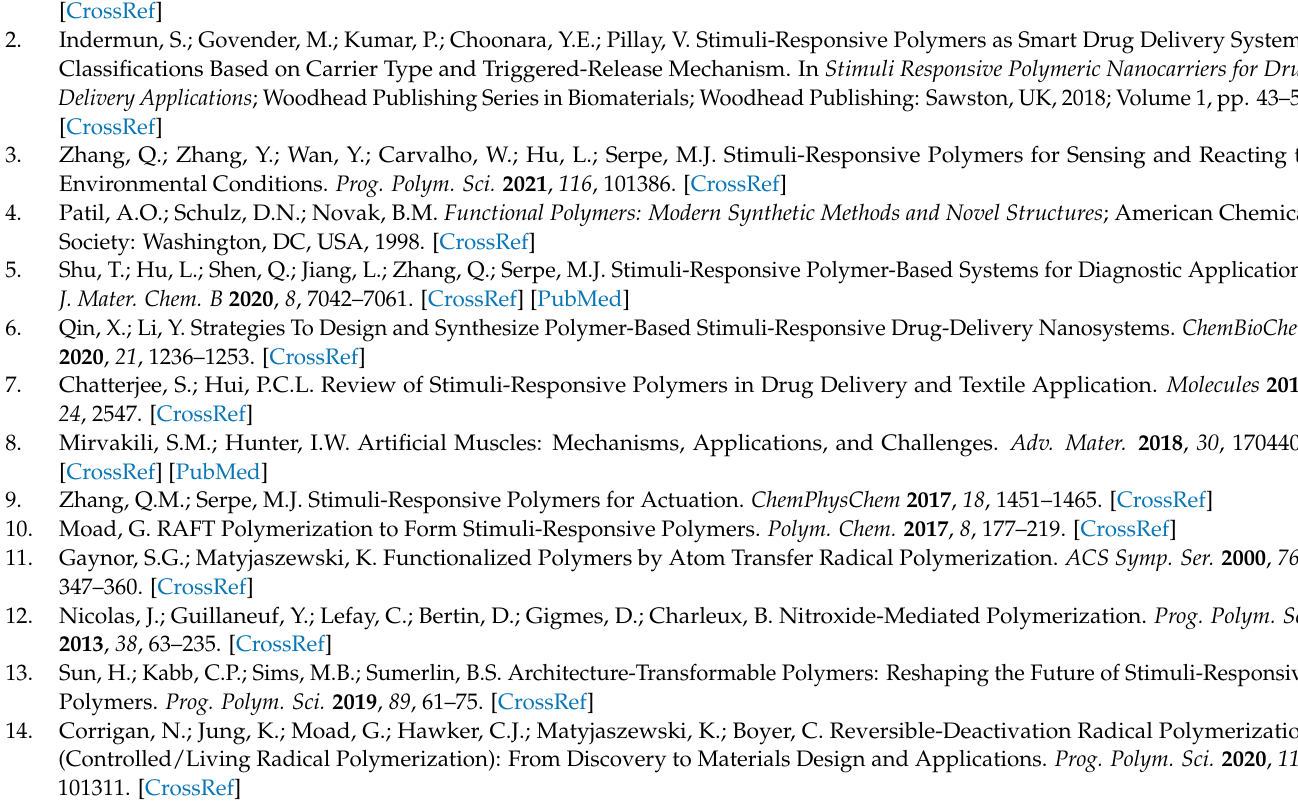
polymerization. Figure S3: The MWD curves obtained from SEC analyses for polystyrene synthesized using different monomer concentration in initial feed (T = 80 ◦ C, t = 24 h, [M]0:[CTA]0:[I]0 = 300:3:1). Figure S4: MWD curves of polystyrene synthesized at different [M]0 to [I]0 ratio in initial feed (T = 80 ◦ C, t = 24 h, [CTA]0:[I]0 = 3, [M]0 = 20%). Figure S5: MWD of polystyrene samples quenched after certain time of RAFT polymerization process (T = 80 ◦ C, [M]0:[CTA]0:[I]0 = 300:3:1, [M]0 = 20%). Table S1: Macromolecular results of synthesized p (St) (1); p (PEO 5 MEMA) (11) and p (St- co -PEO 5 MEMA) copoly- mers with various compositions